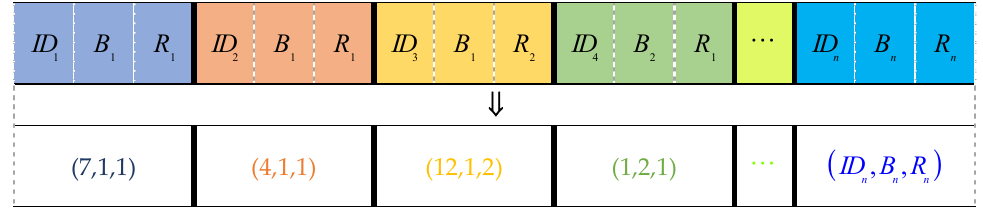
Figure 5. Schematic diagram of chromosome coding.